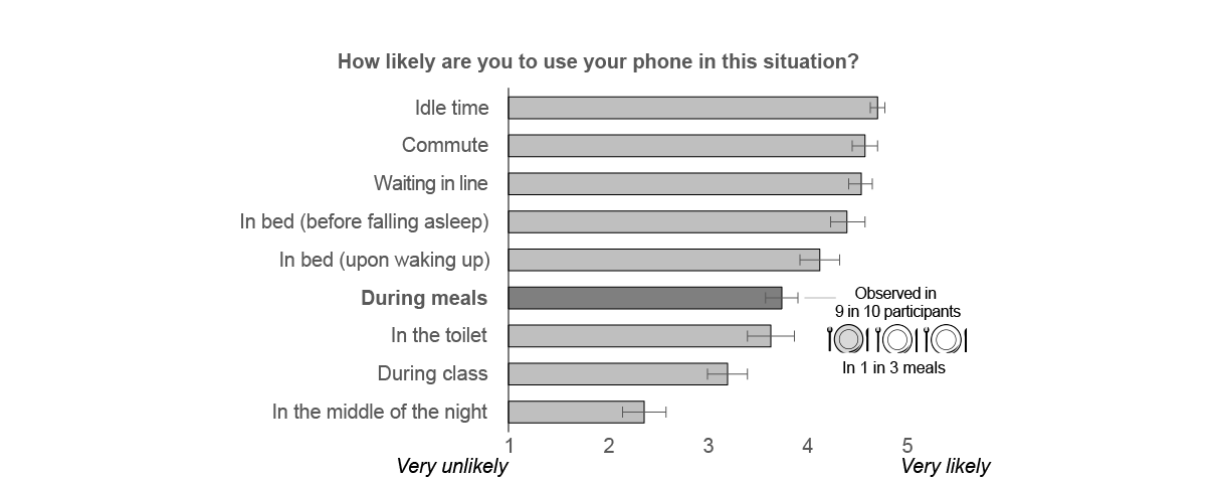
Figure 1. In a baseline questionnaire on habitual phone use, participants reported how likely they were to use their phones in each context. A higher score corresponds to greater likelihood, and horizontal lines represent the 95% CI for the mean. When participants were then monitored for 1 week, mealtime phone use was observed in approximately 9 of 10 participants (in an average of 1 in 3 meals).